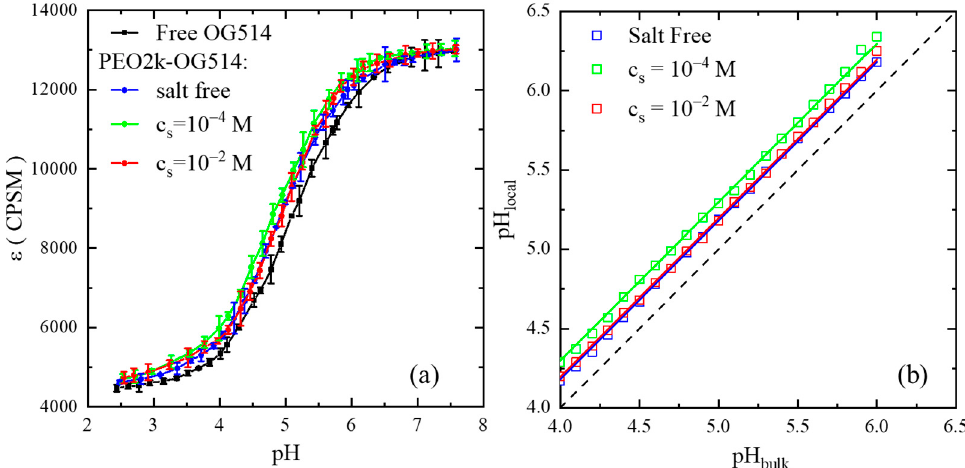
Figure 4. ( a ) Values of the molecular brightness ( ε ) of OG514 as a function of pH in the solution when it is free and attached to the chain-end of PEO2k under different salt concentrations. ( b ) Values of local pH at the PEO chain-end as a function of the pH value of the solution. The dashed line denotes the results of free OG514.